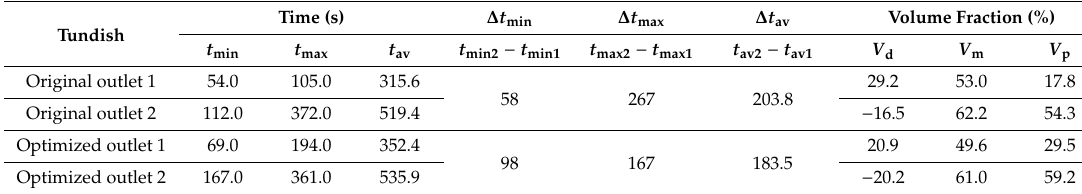
Figure 7. RTD (residence time distribution) curves in the tundish. Figure 7. RTD ( residence time distribution) curves in the tundish. Table 5. Fluid flow characteristics in the original and optimized